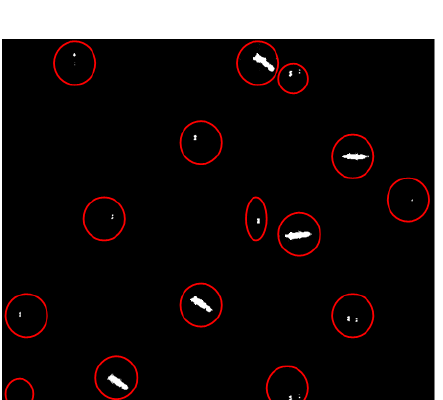
Figure 2. ship detection result